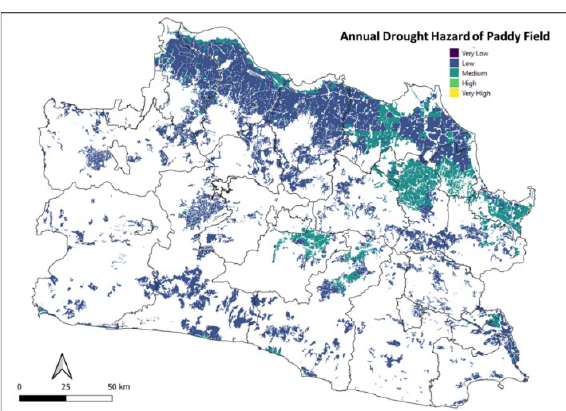
Figure 7 . Drought hazard model in the rice fields in